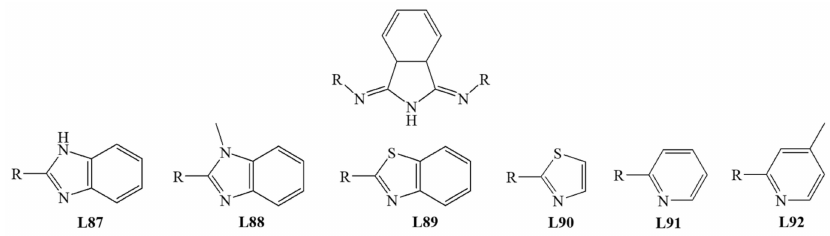
Figure 11. Tridentate N and O donor ligands.